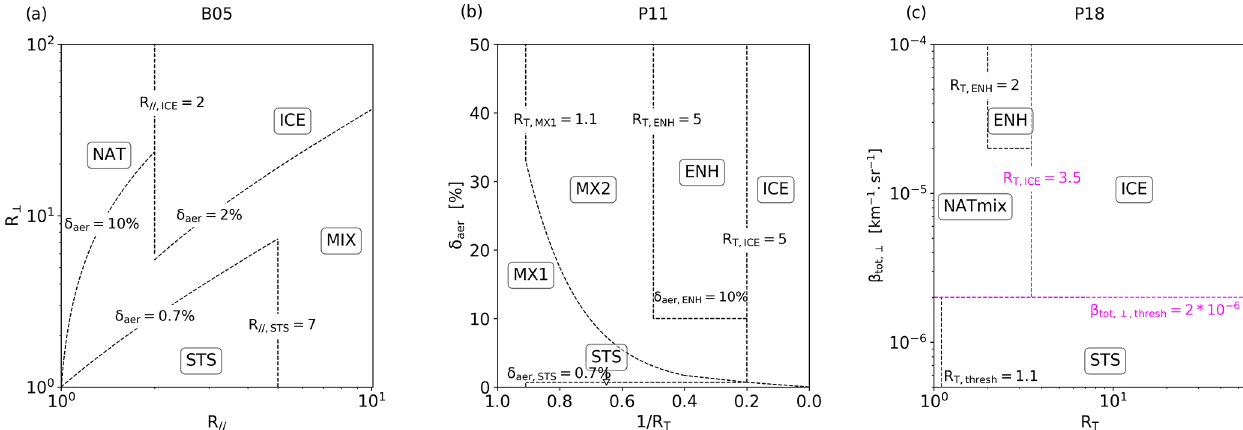
Figure 2. The three classification schemes considered in the paper: B05 (a) , P11 (b) and P18 (c) . The relevant thresholds are specified. The two dynamic thresholds are coloured in fuchsia and the given values are only for visualization